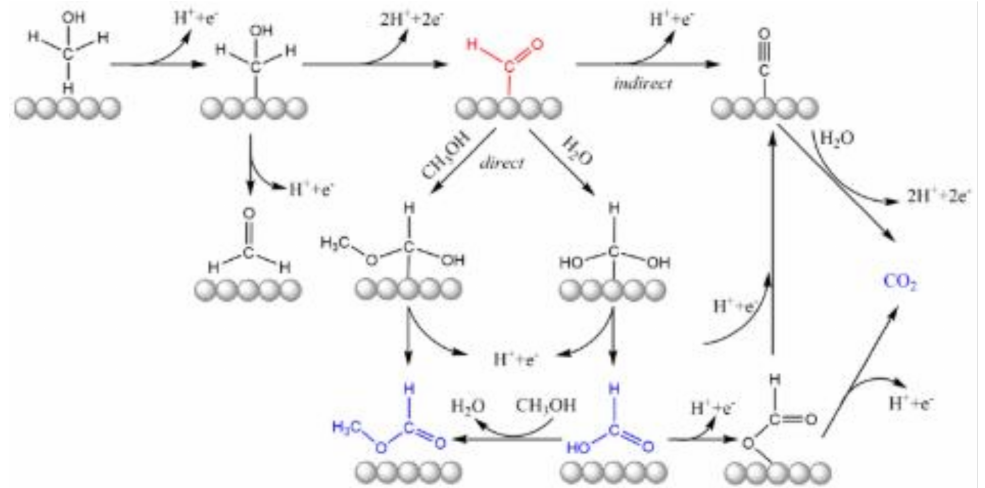
Figure 3. Proposed mechanism of methanol oxidation via direct and indirect way. Reprinted with permission of American Chemical Society